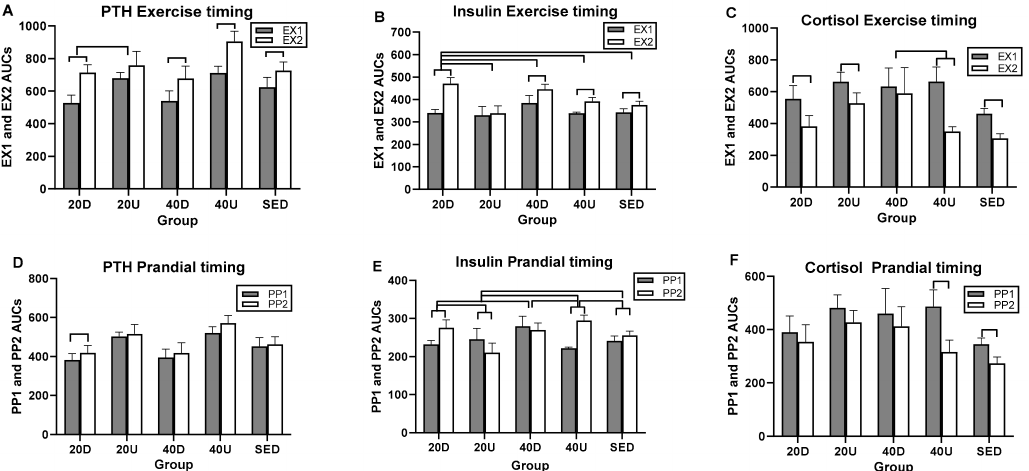
Figure 8. Between- and within-group comparisons for timing effects of EX1 and EX2 and PP1 and PP2 AUCs on PTH ( A , D ), insulin ( B , E ), and cortisol ( C , F ). D = down AUCs, U+Up AUCs, S = sedentary